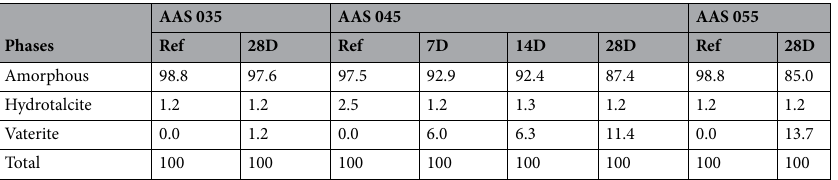
Table 3. Quantitative phase analysis for reference and carbonated AAS specimens at three w/b ratios. Ref uncarbonated samples, 7D, 14D, 28D 7-day, 14-day and 28-day carbonated samples, respectively.